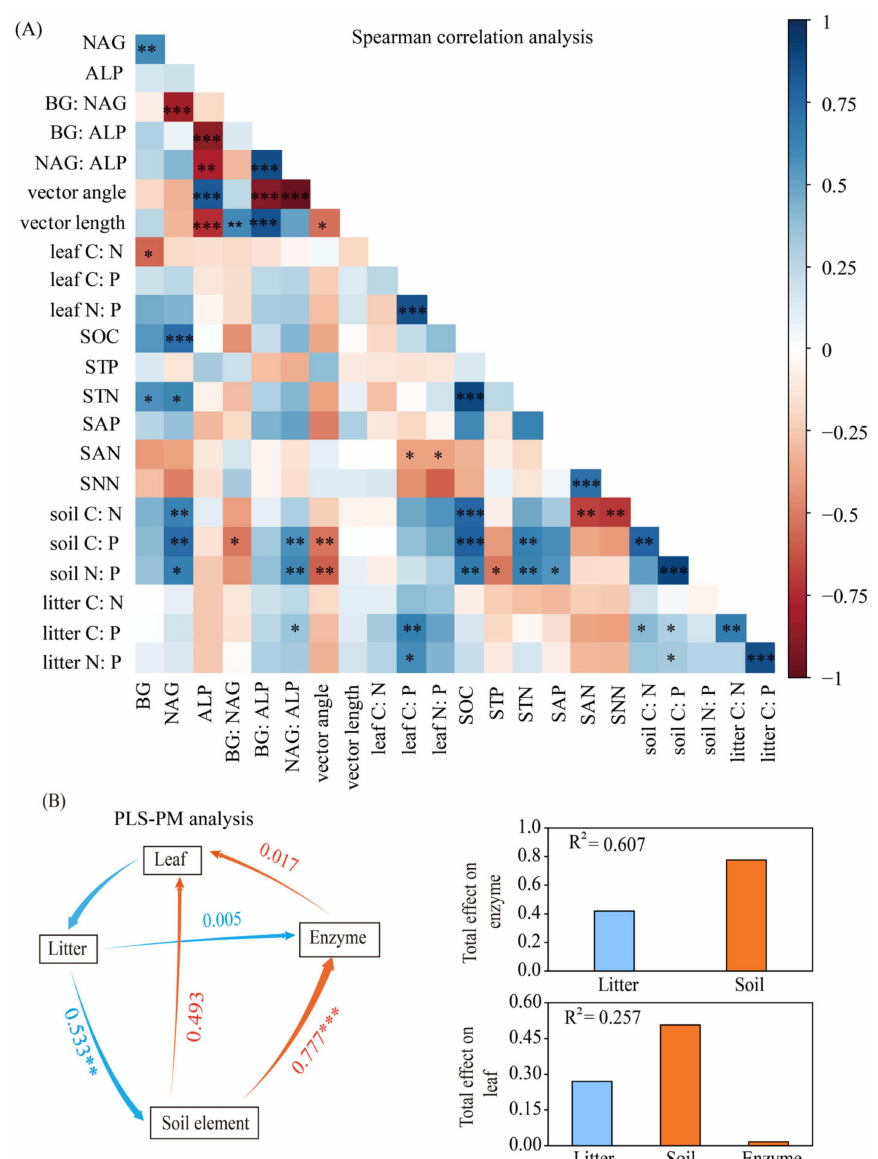
Figure 6. Relations of stoichiometry within the plant–soil continuum. ( A ) Correlations of stoichiom- etry among plant leaf, litter, soil, and enzyme activity. ( B ) Pathway effects between plant and soil system (soil element and enzyme) calculated by partial least squares path modeling (PLS-PM). The blue arrows represent the effect of litter on soil element and enzyme activity stoichiometries, and the orange arrows indicate the effect of soil system on leaf stoichiometries. (*, **, and ***) represent significant correlations at 0.05, 0.01, and 0.001 levels,